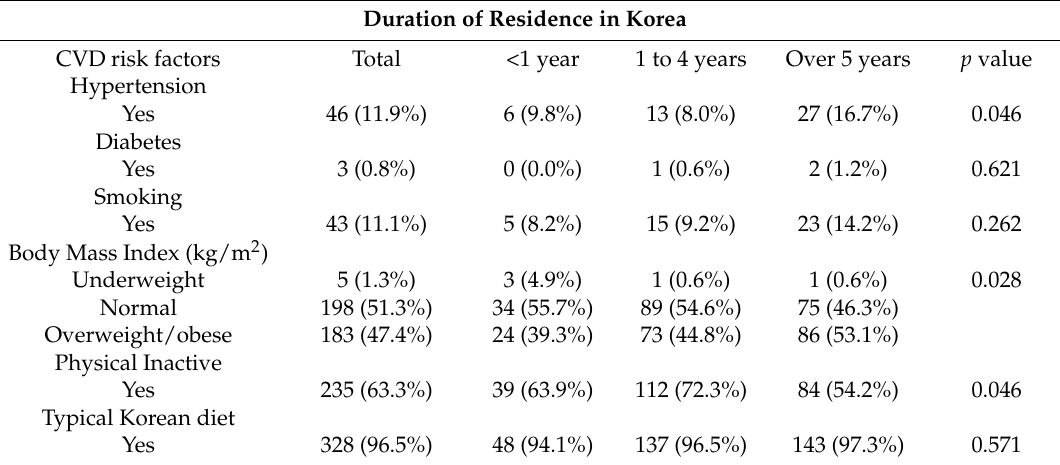
Table 3. Association between length of residence and cardiovascular risk